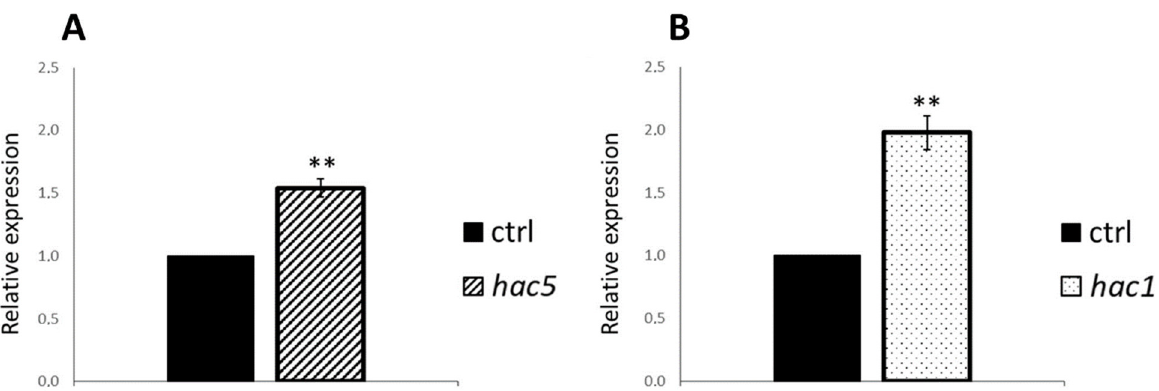
Figure 7. HAC1 and HAC5 mutually regulate their expression. Relative expression level of HAC1 ( A ) and HAC5 ( B ) in 6-day-old dark-grown wild type (control, ctrl), hac5 and hac1 mutant seedlings, respectively. RT-qPCR assays were performed with 1 µ L of the diluted cDNA, along with the specific primers, listed in Table S1. Relative expression levels were normalized with the GAPA1 (AT3G26650) and UBQ10 (AT4G05320) reference genes. The values of relative expression level are means of three biological replicates, presented with SD values. Significant differences were analyzed by t -test (** p ≤ 0.005).